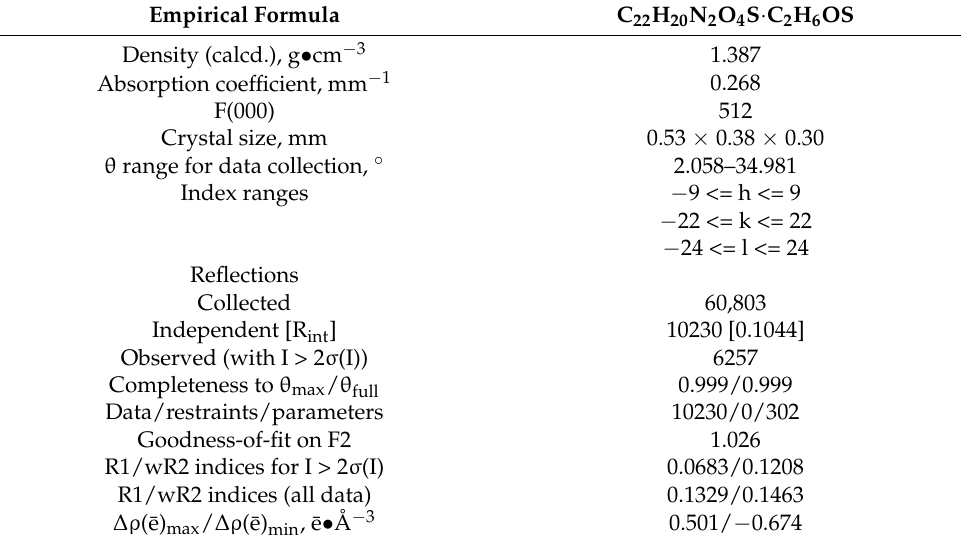
Table 2. Cont. Empirical